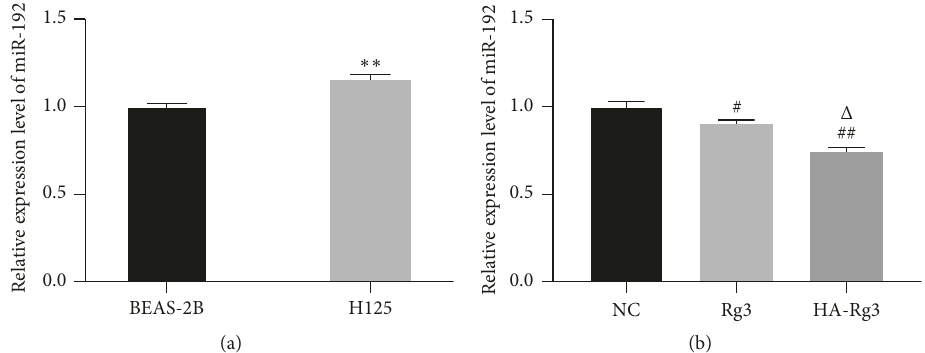
Figure 2: Effect of HA-Rg3 bio-polymerized nanoparticles on the expression level of miR-192. (a, b): The relative expression level of miR- 192. ∗∗ P < 0 . 01 vs the BEAS-2B group; # P < 0 . 05 and ## P < 0 . 01 vs the NC group; △ P < 0 . 05 vs the NC group.